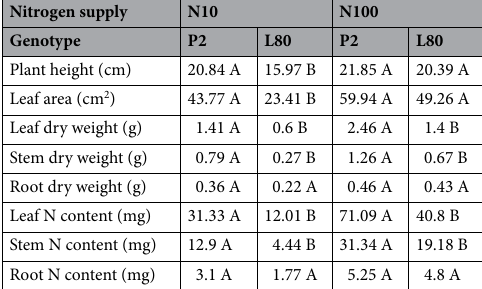
Nitrogen supply N10